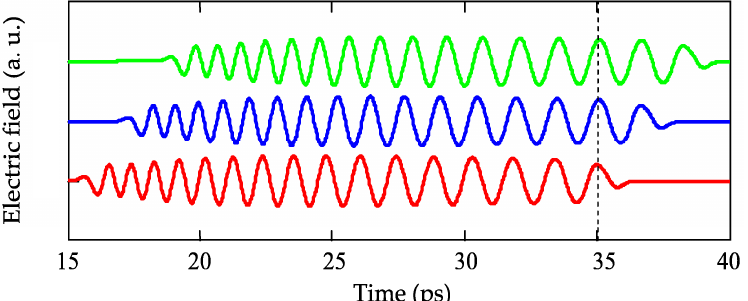
Figure 2. The temporal forms of THz pulses generated in the APPLN crystal by original laser pulse (red line) and its replicas delayed at Δ t 2 (blue curve) and Δ t 3 (green curve). The dashed line indicates nearly perfect overlapping of the fields radiated from the first three positive domains, when they are excited by laser pulses with the delays of Δ t 1 = 0, Δ t 2 , and Δ t 3 .